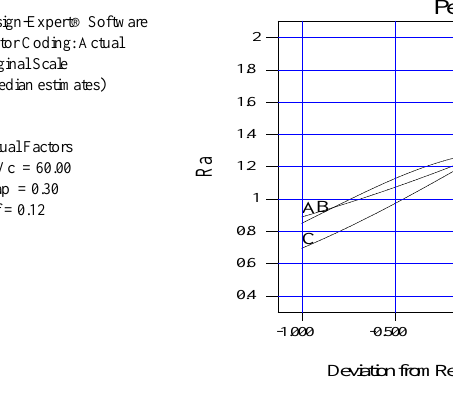
Fig. 2. Perturbation plot for